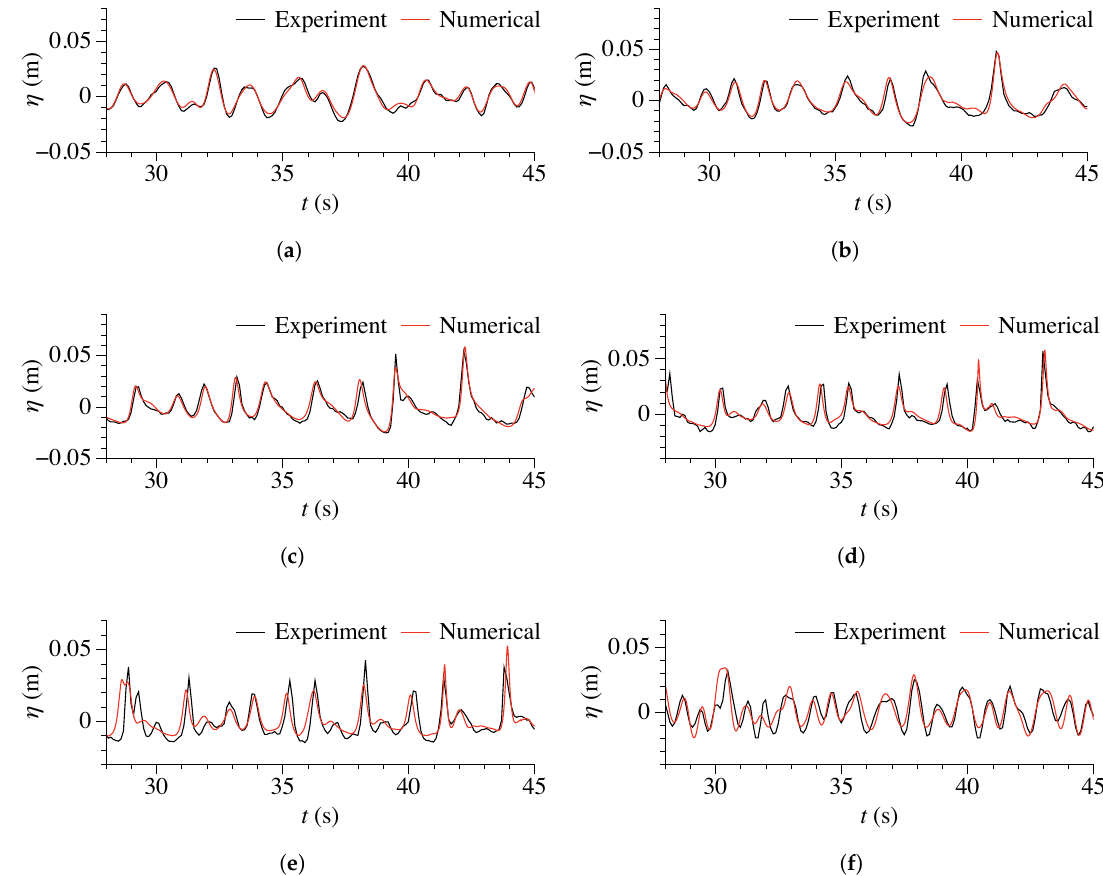
Figure 6. Comparison of the experimental and reconstructed irregular wave signal for breaking irregular waves ( a ) W1 ( x = 6 m); ( b ) W2 ( x = 11 m); ( c ) W3 ( x = 12 m); ( d ) W4 ( x = 13 m); ( e ) W5 ( x = 14 m); ( f ) W6 ( x = 16